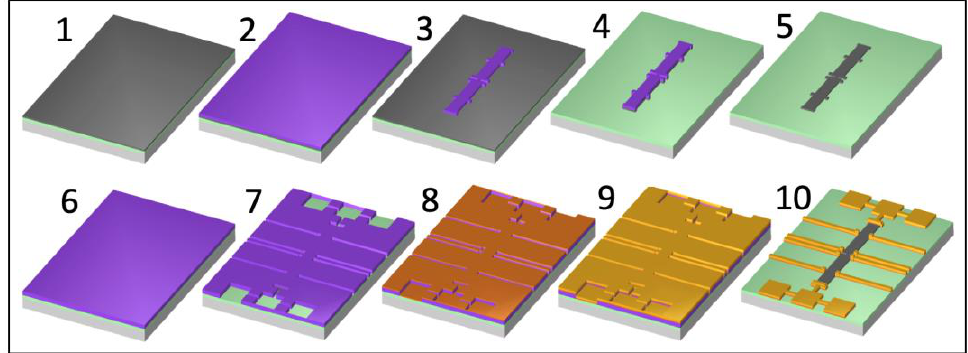
Figure 2 . Overview of the fabrication process. ( 1 ) 4” wafer with graphene on SiO 2 /Si or hBN/SiO 2 /Si. ( 2 ) Graphene patterning: deposition and exposure of photoresist layer with 1st mask. ( 3 ) Photoresist layer after developing of 1st mask pattern. ( 4 ) Removal of graphene in non-patterned areas with O 2 plasma etch. ( 5 ) Acetone removal of 1st photoresist layer. ( 6 ) Metal patterning: deposition and exposure of photoresist layer with 2nd mask. ( 7 ) Photoresist layer after developing 2nd mask pattern. ( 8 ) Deposition of 5 nm Cr layer. ( 9 ) Deposition of 50 nm Au layer. ( 10 ) Liftoff of 2nd mask photoresist and excess metal.